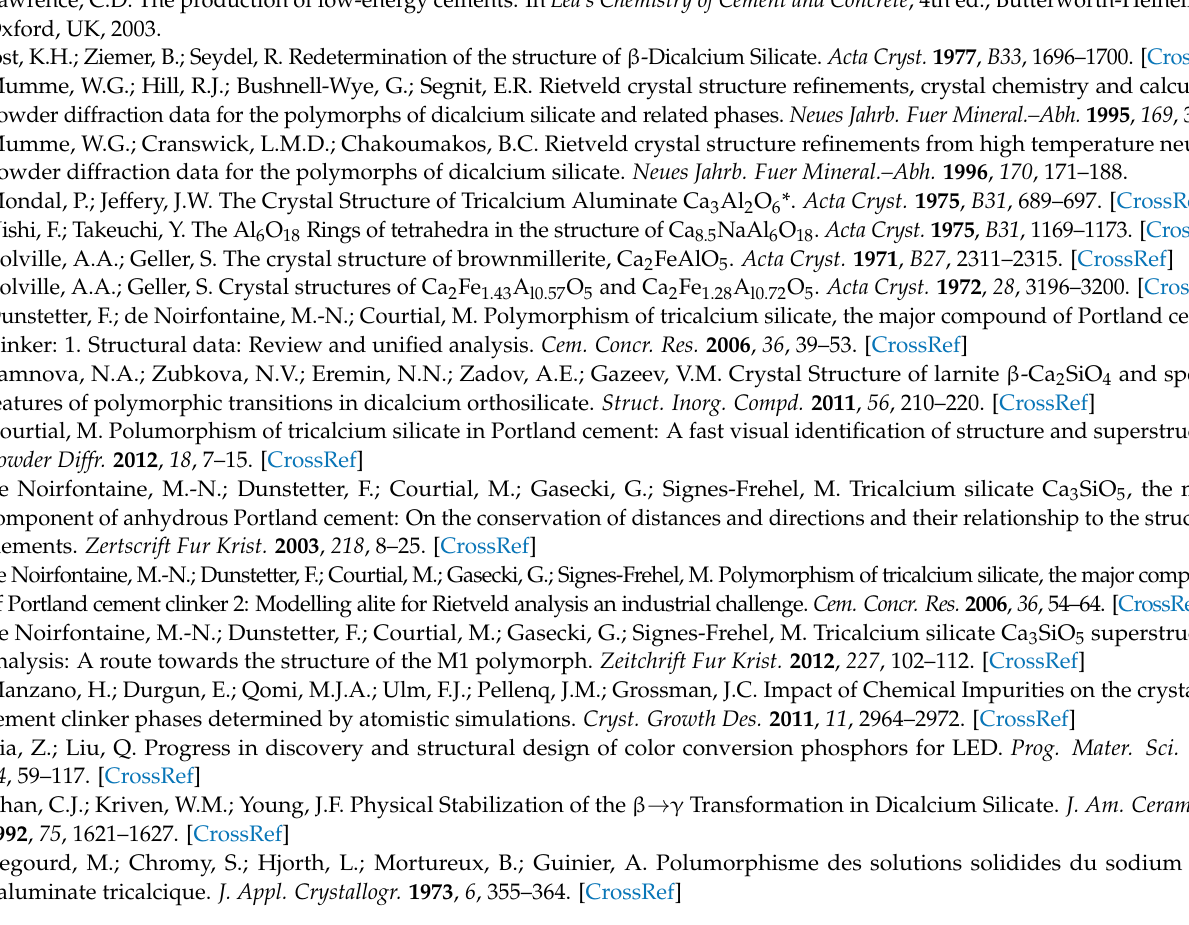
Table S2: trigonal prism and the atoms at the equator Crystallographic parameters for all studied structures . ; Table S3: Transformation matrices of the unit cell axes which relate the cell axes of each belite polymorph with the hexagonal axes of the α -C2S